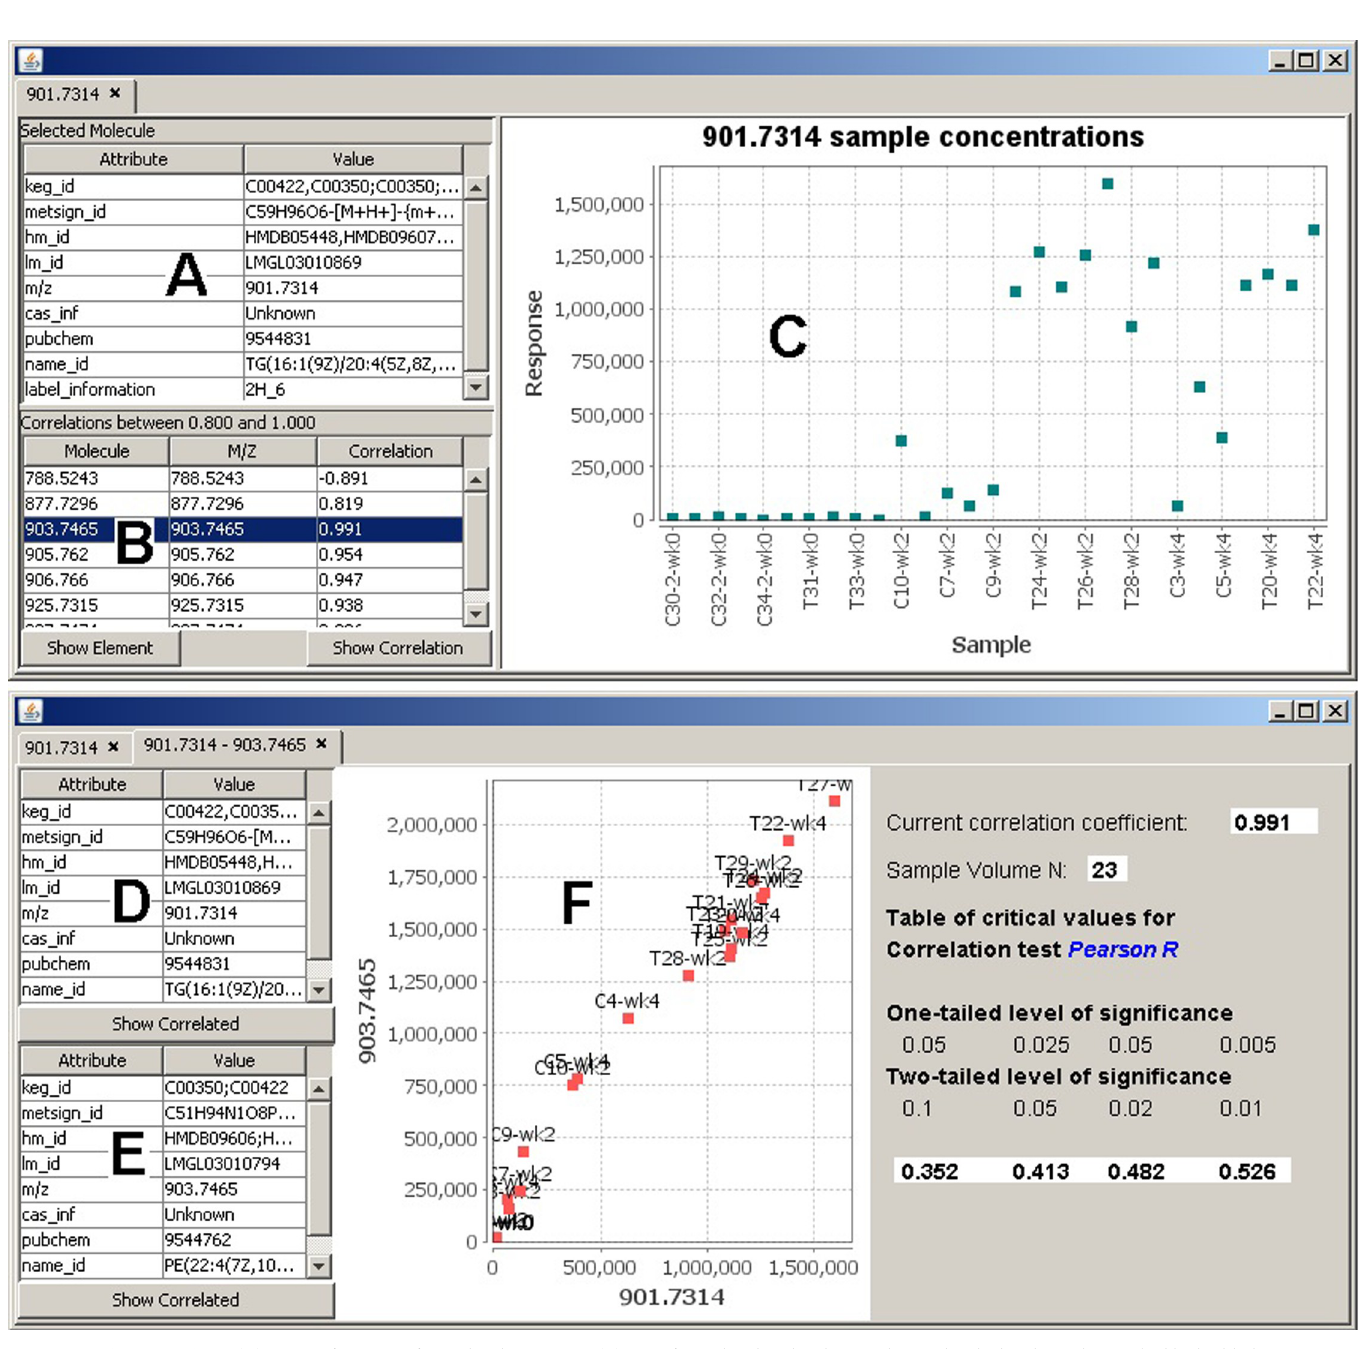
Fig 4. Correlation analysis. (A) Meta information for molecule 901.7314. (B) List of correlated molecules. Further molecule details can be invoked by highlighting a molecule in this list and choosing wither the “Show Element” or “Show Correlation” buttons. (C) Molecular concentration levels across all samples. (D) Concentration details for molecule 901.7314. (E) Concentration details for correlated molecule 903.7465. (F) Correlation graph showing the expression data of the two molecules. Each point represents the expression levels of both molecules (x-axis and y-axis) in the same